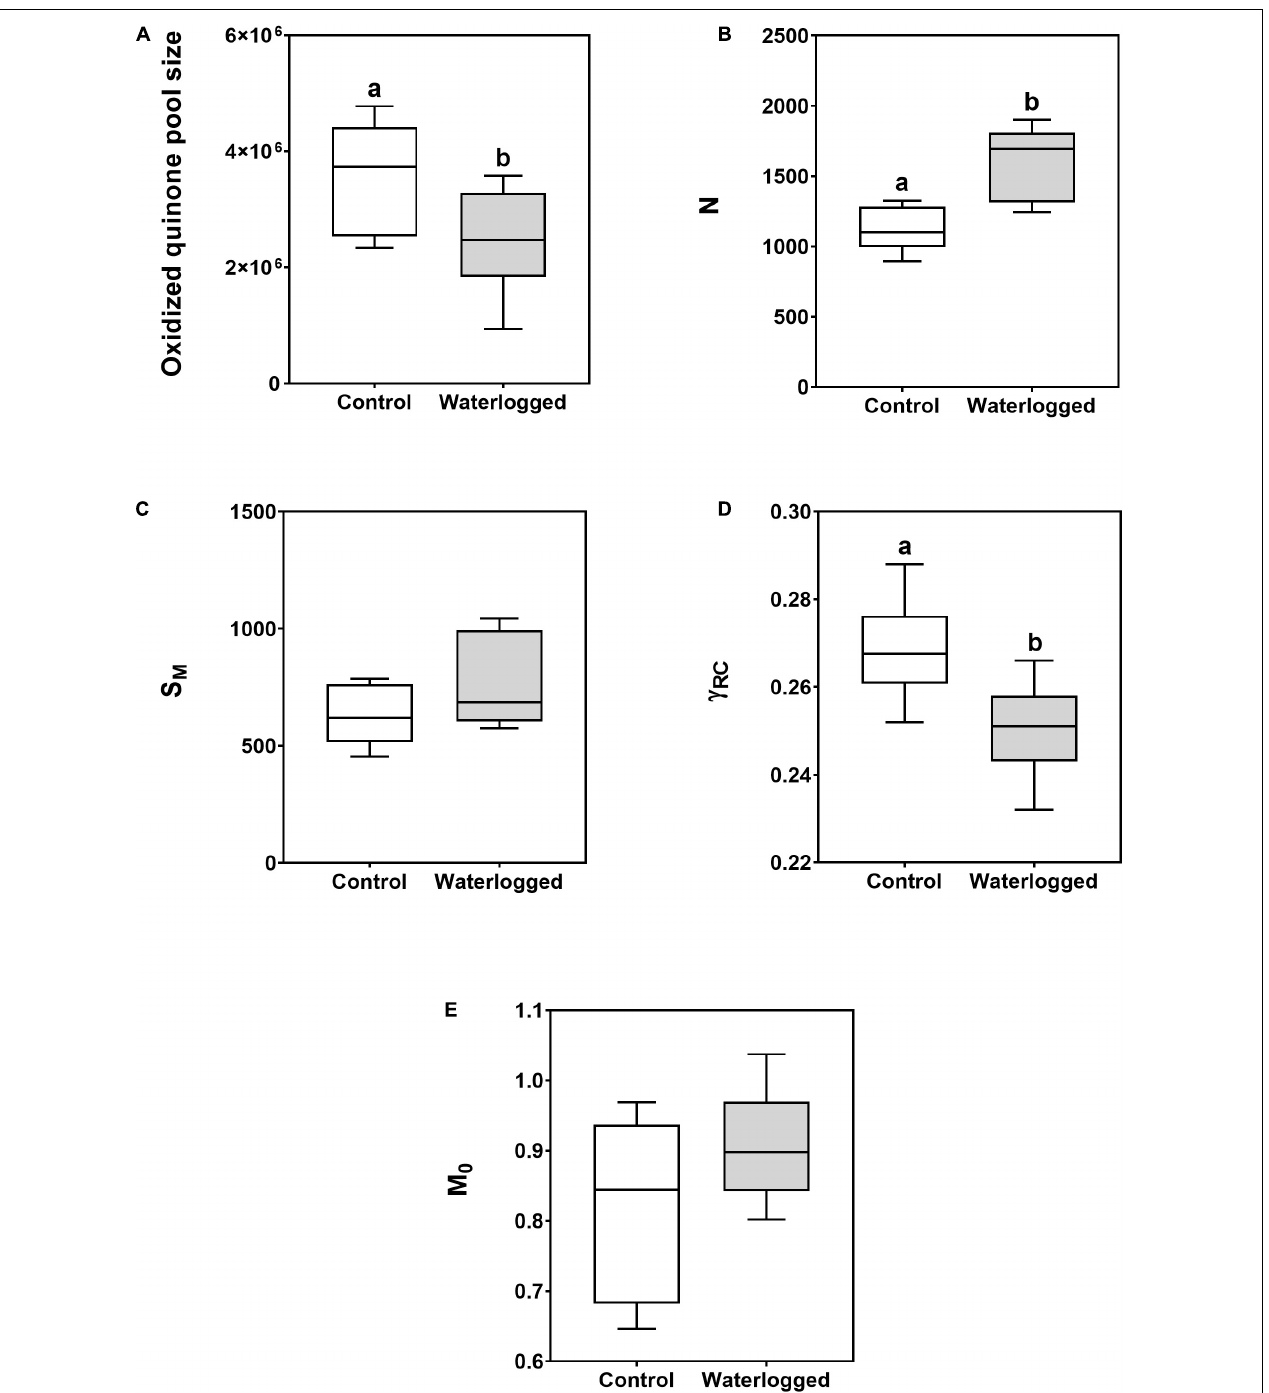
FIGURE 4 | Boxplots of the photosystem II and ETC related photochemical traits [ A , oxidized quinone pool; B , reaction center turnover rate (N); C , the energy needed to close all reaction centers (S M ); D , the probability that a PSII chlorophyll molecule function as a RC ( γ RC ); E , net rate of PS II RC closure (M 0 )], in leaves of control plants (white boxes) and waterlogged plants (gray boxes) of Spartina patens after 30 days ( n = 10, different letters indicate significant differences at p < 0.05).